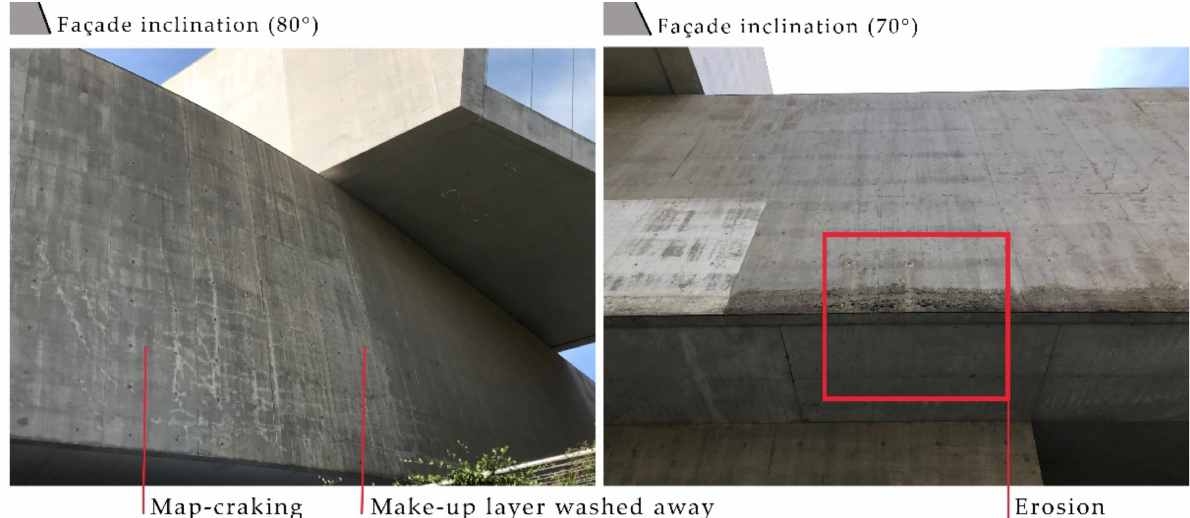
Figure 8. MAXXI, Rome (2010). Concrete pathologies affecting the façade (ph. Cardellicchio,